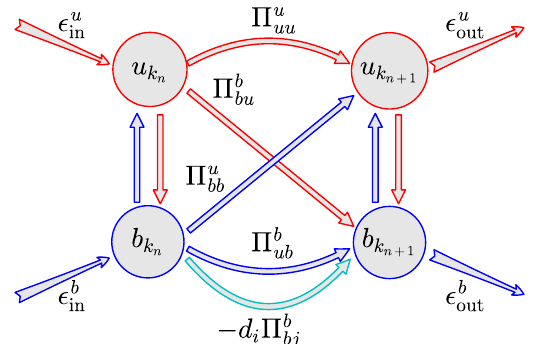
FIG. 5. Schematic representation of various energy fluxes at a given scale in the inertial range of Hall MHD turbulence. Note that because kinetic and magnetic energies are not conserved separately, nontrivial energy fluxes inside the same wave-vector domain may exist (vertical arrows). The arrows labeled ϵ u;b in ; out represent the different incoming or outgoing energy fluxes. FIG. 6. Normalized energy fluxes versus k ⊥ d i (run